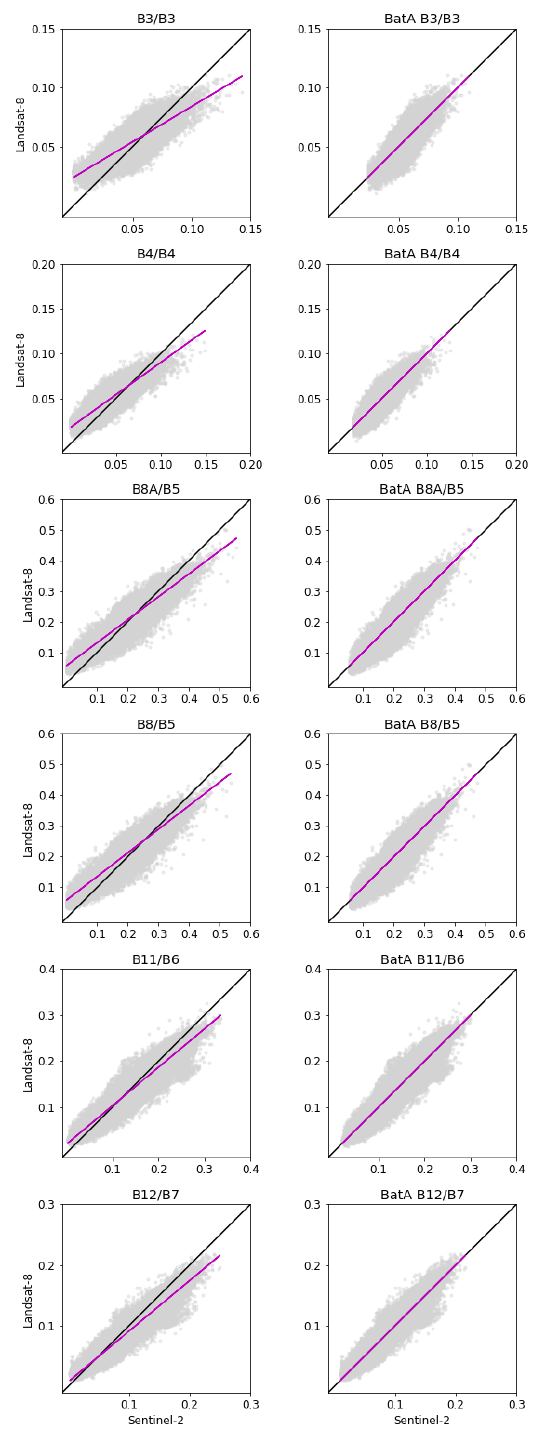
Figure A1. Comparison of surface reflectance values from the Sentinel-2 and Landsat-8 corresponding bands for Batagay. Left plots: observed surface reflectance values. Right plots: Batagay Adjusted (BatA) Sentinel-2 reflectance values. The solid black line is one-to-one, and the pink line is the ordinary least squares regression trend